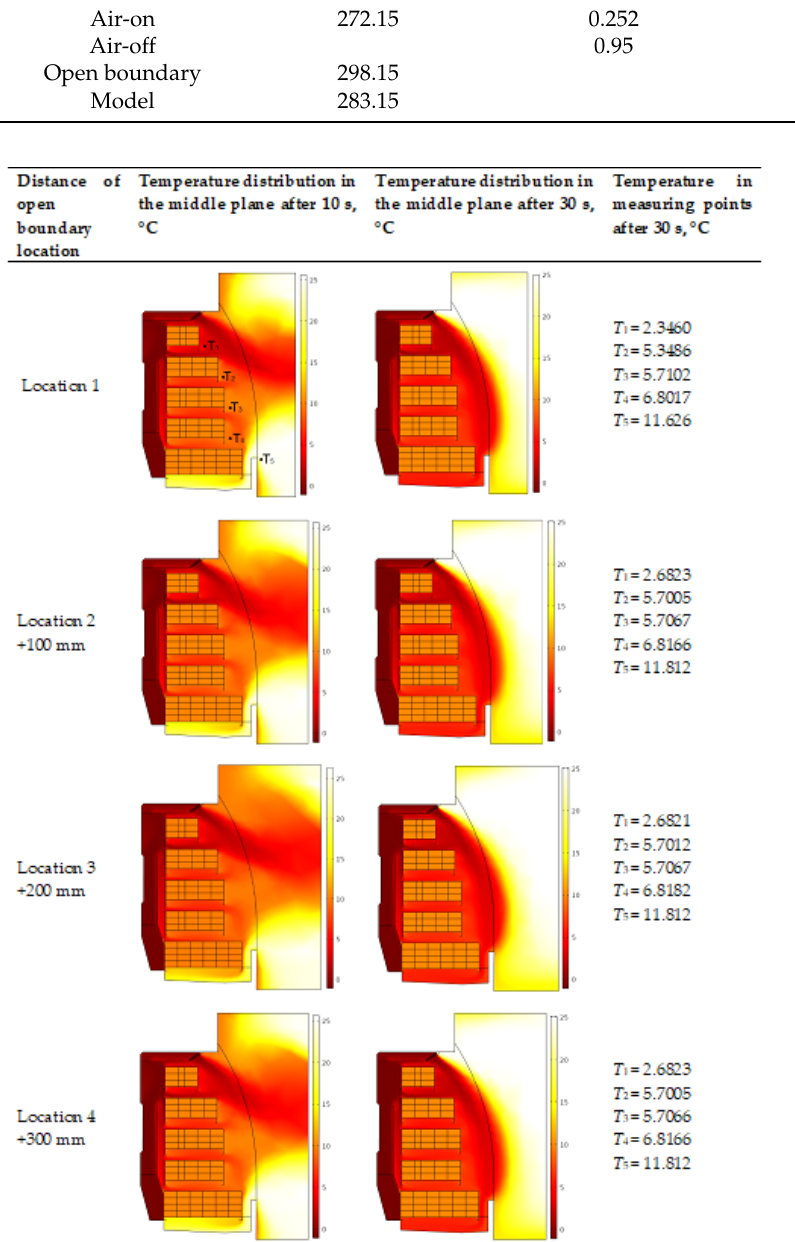
Table 3. Boundary conditions.